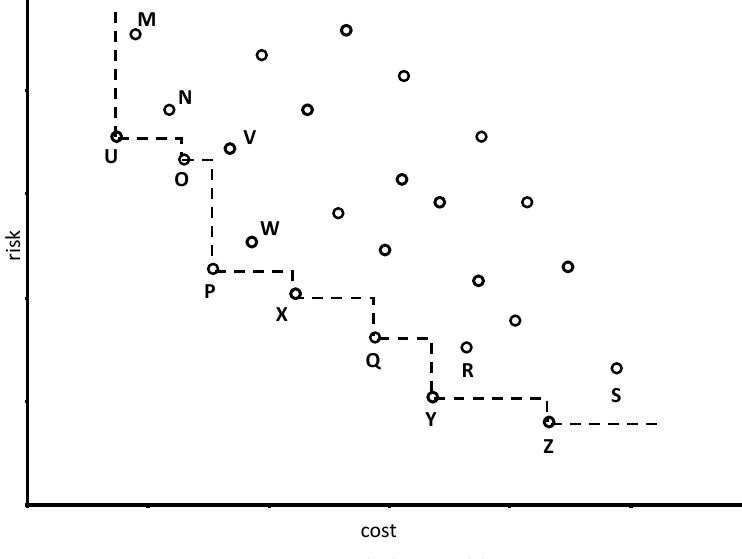
Figure 1. A skyline